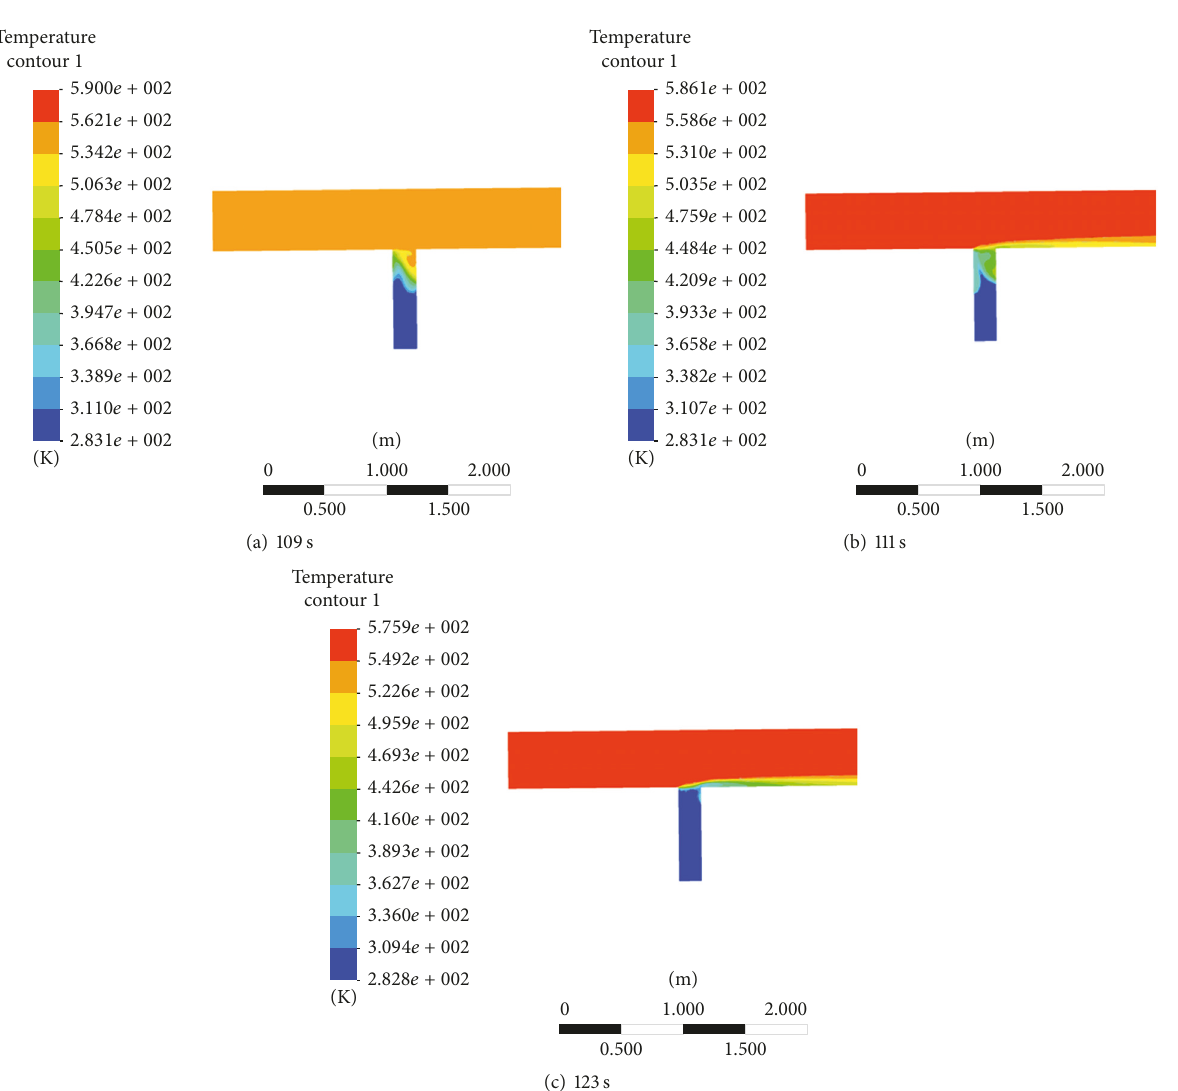
Figure 19: Temperature distribution of the T-junction in the second